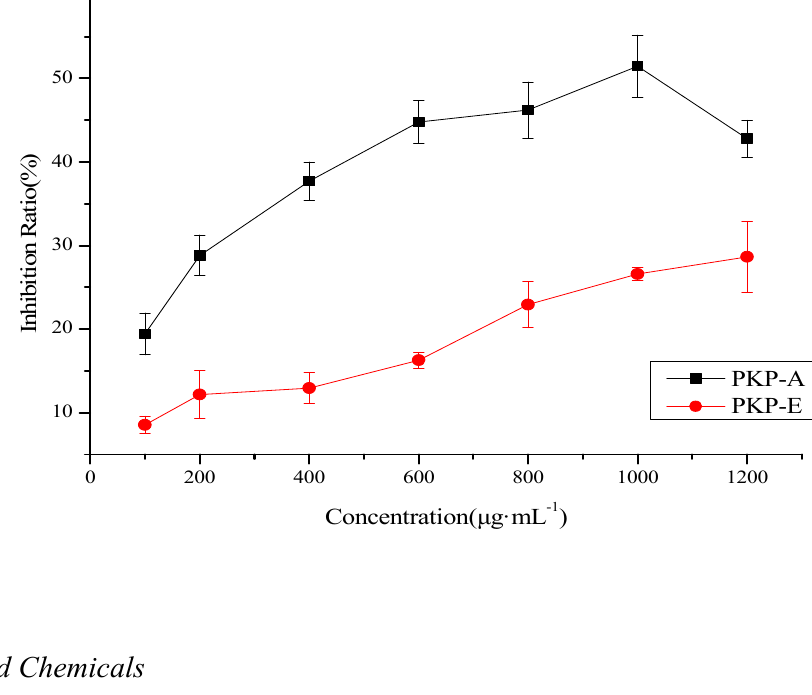
Figure 5. Inhibition rates of PKP-A and PKP-E on